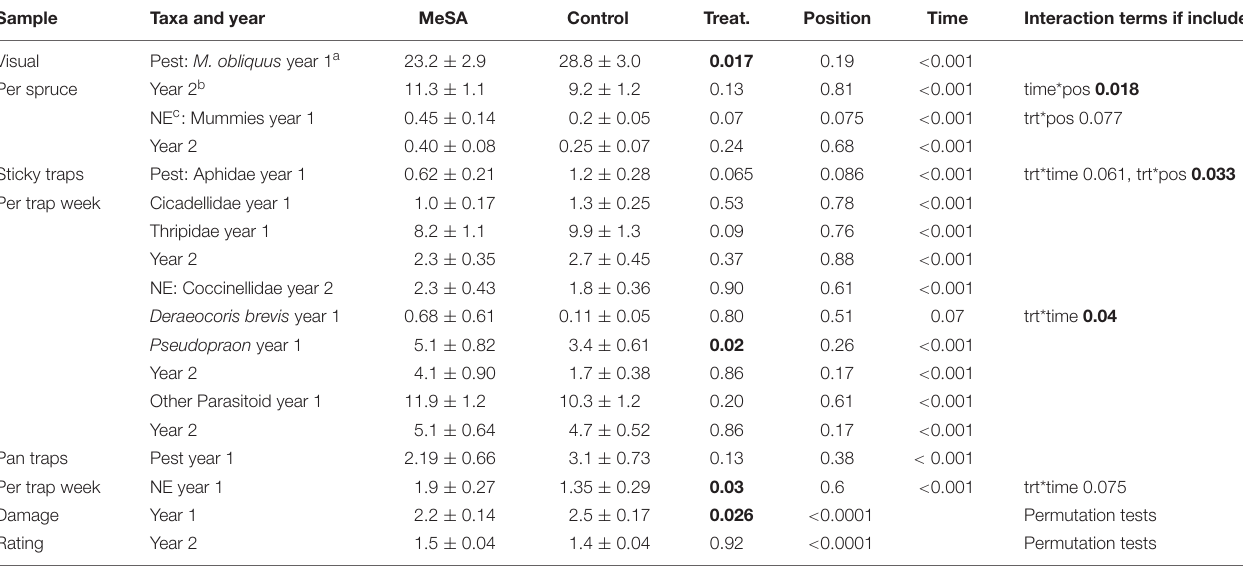
TABLE 2 | Mean counts ( ± SE) of insects in spruce container yards with and without MeSA lures, and p -values from